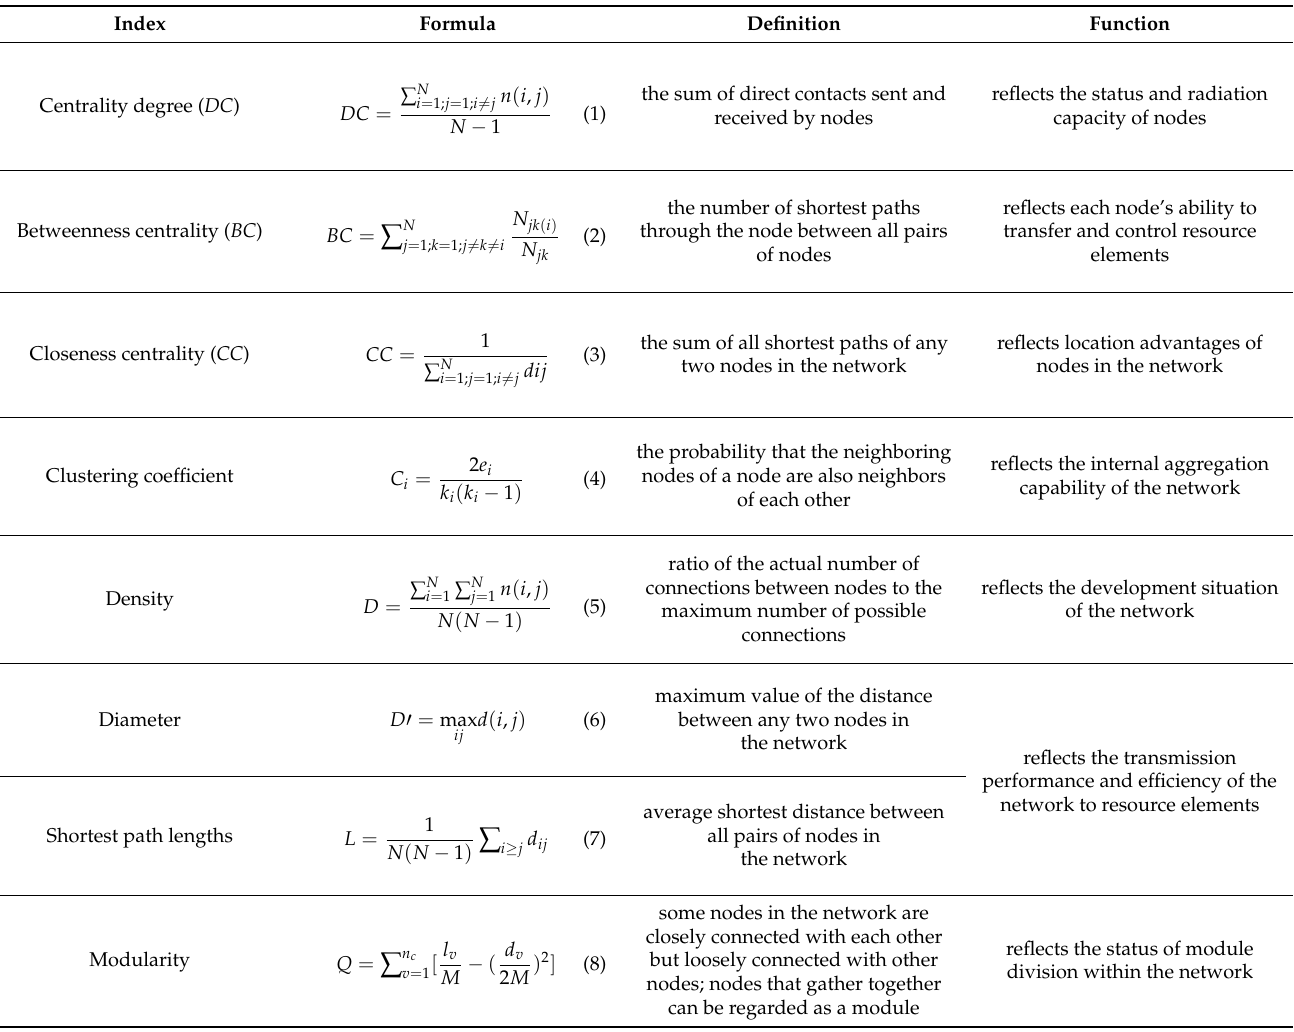
Table 1. An overview of social network analysis